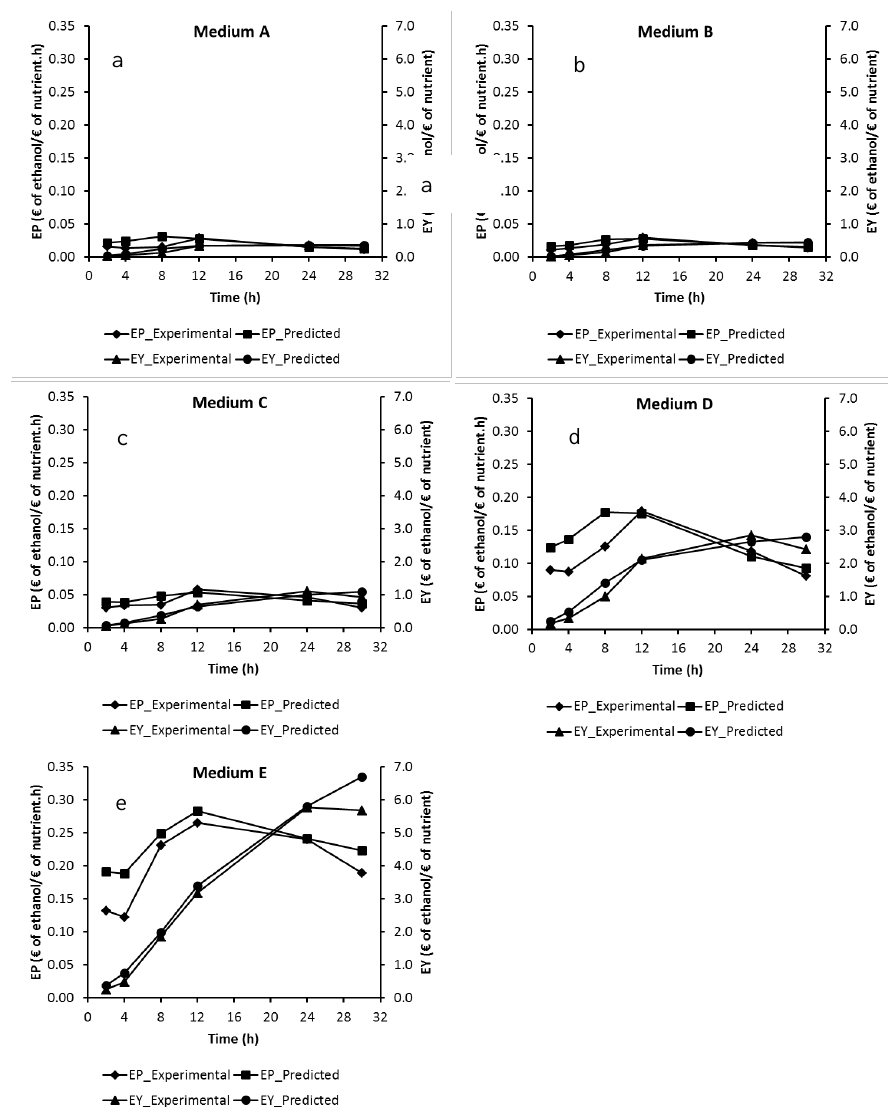
Figure 5. Dynamic profiles of economic productivity, EP, and economic yield, EY, studied for the kinetic experiment at different nutritional compositions.